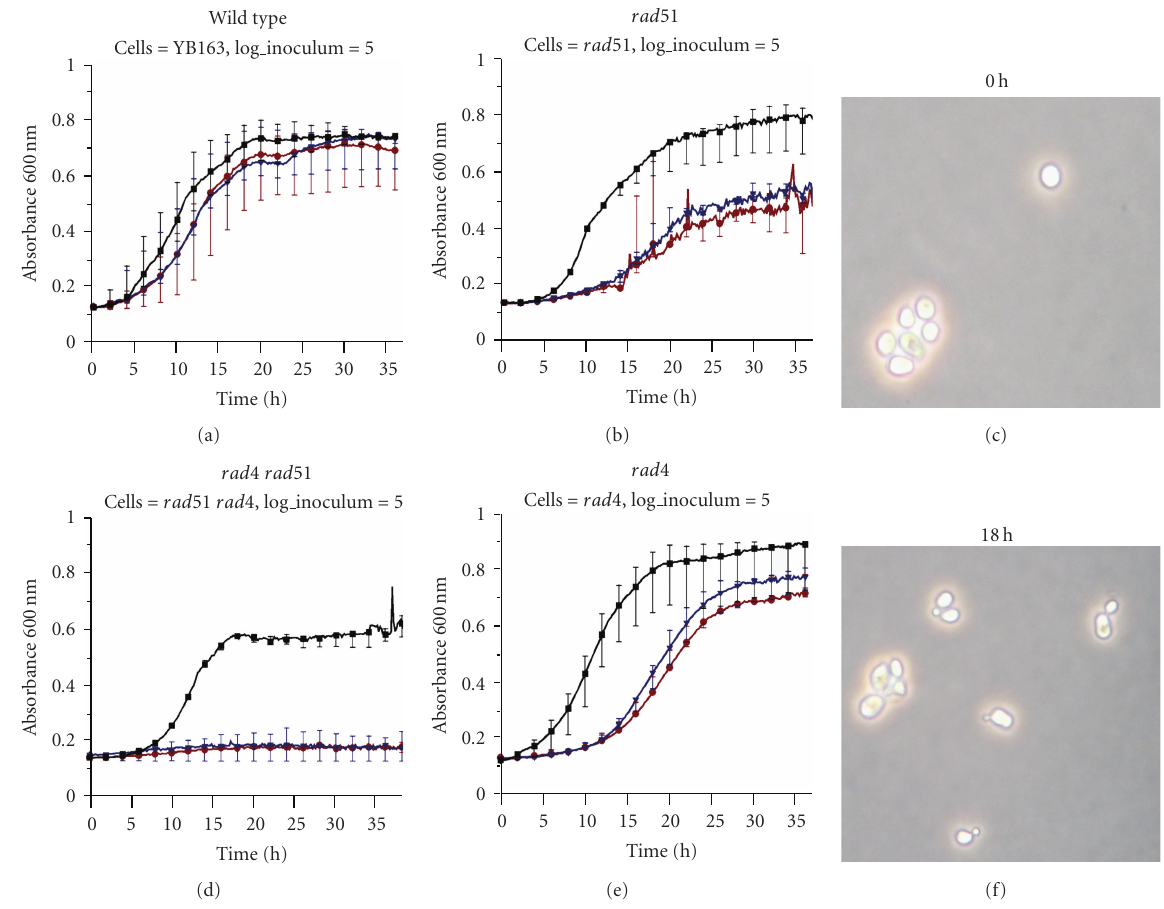
Figure 3: Growth of wild type (a), rad51 (b), rad4 (e), and rad4 rad51 (d) cells after exposure to AFB 1 . (Left) Growth of cells containing pCS316 and expressing CYP1A2 after chronic exposure to 0 μ M (black), 25 μ M (blue), and 50 μ M (red) AFB 1 . The relevant genotype is given below the panel (see Table 1, for complete genotype). 10 5 log-phase cells were inoculated in each well, n = 3. A 600 is plotted against time (h). (Right ) rad4 cells synchronized in G1 were exposed to 50 μ M AFB 1 for 3 hrs, washed, and inoculated on YPD. Cell growth was monitored from 0–18 hrs. Bars indicate the actual range of